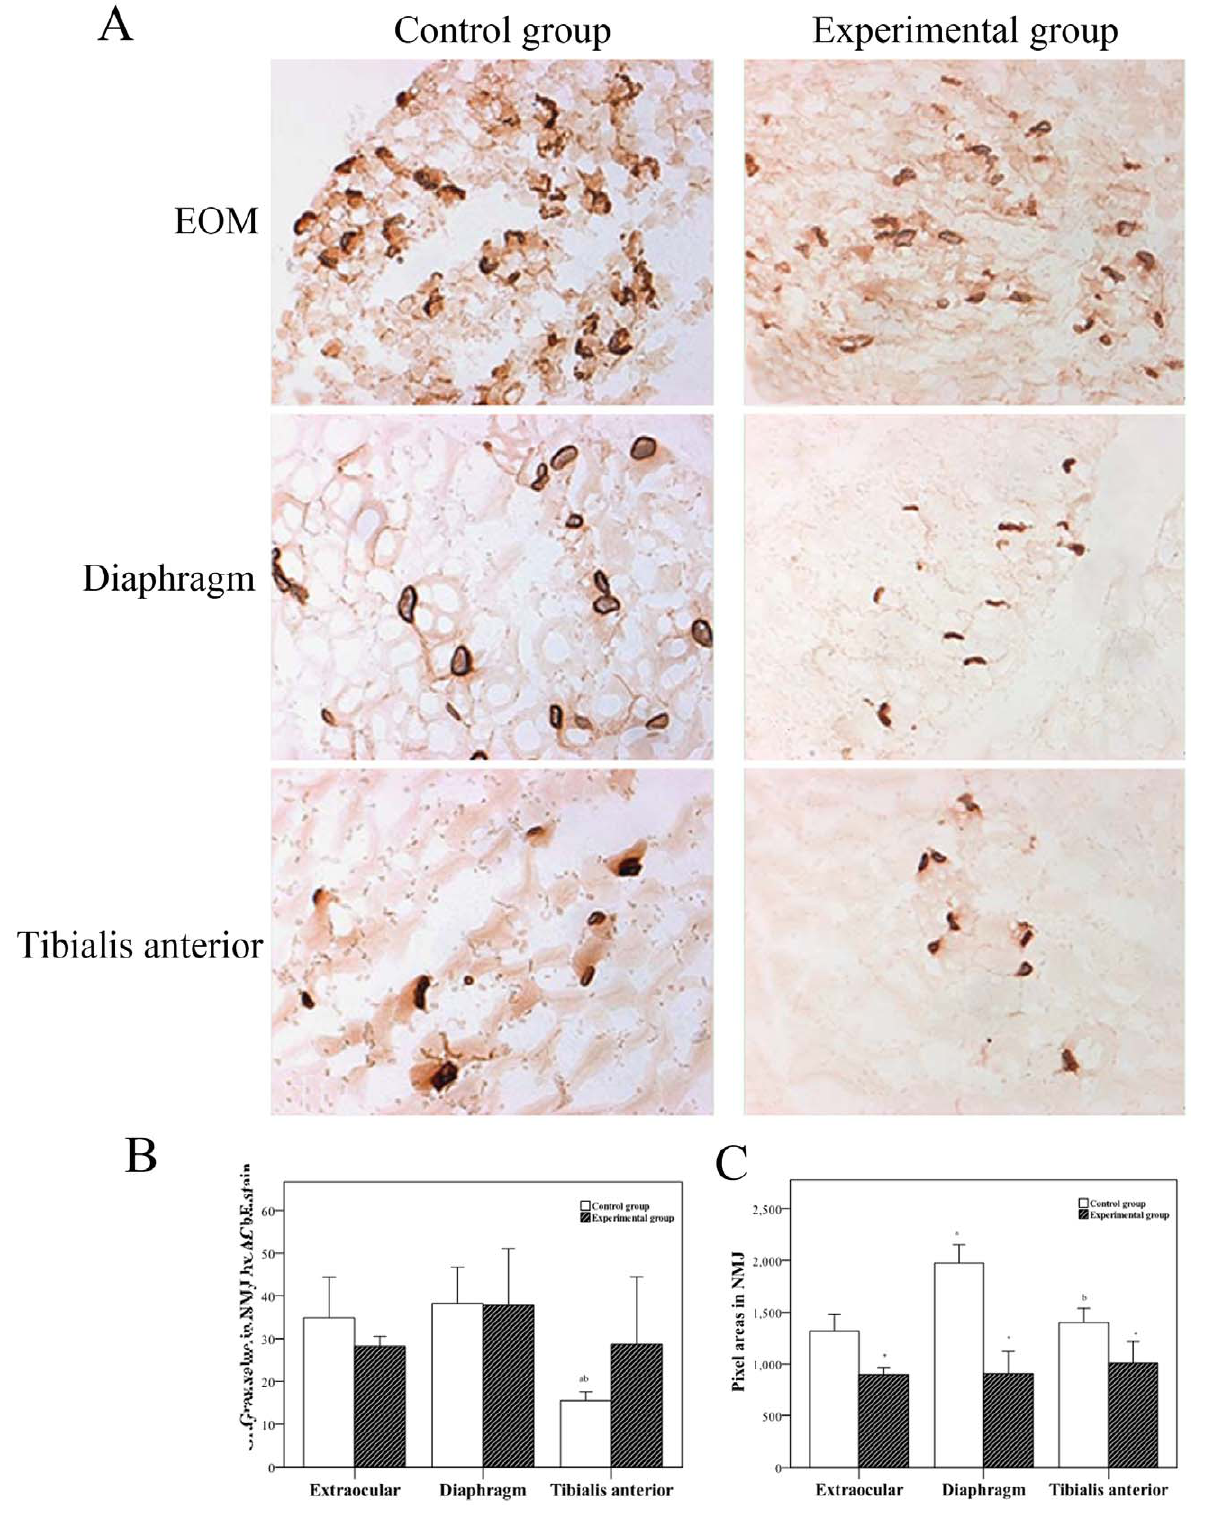
Figure 3. Comparision of NMJs from different muscles. A. Acetylcholinesterase (AChE) staining of three muscles in the two groups. B. Determination of gray value in NMJ by an automatic analyzer (DM2500,Leica,Germany). C. Determination of pixel areas in NMJ by an automatic analyzer. *Significant ( P , 0.05) difference between control and experimental groups determined by independent two-sample t test. a Statistically significant difference between indicated group and EOM group. b Statistically significant difference between indicated group and diaphragm group. Scale bar=20 m m.